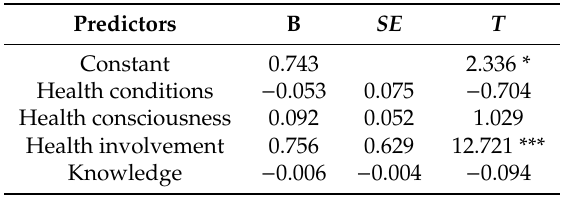
Table 5. Multiple regression results of behavioral